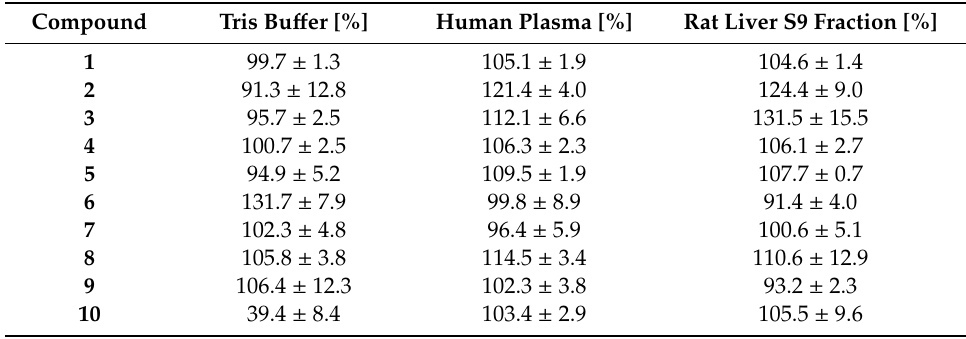
Table 1. Results of stability studies of synthesized compounds 1 – 10 (at the concentrations of 100 µmol/L) after 6 h-incubation (37 °C) in Tris buffer (pH = 7.4), human plasma and rat liver S9 fraction. The results are presented as mean ± SD, n = 3.